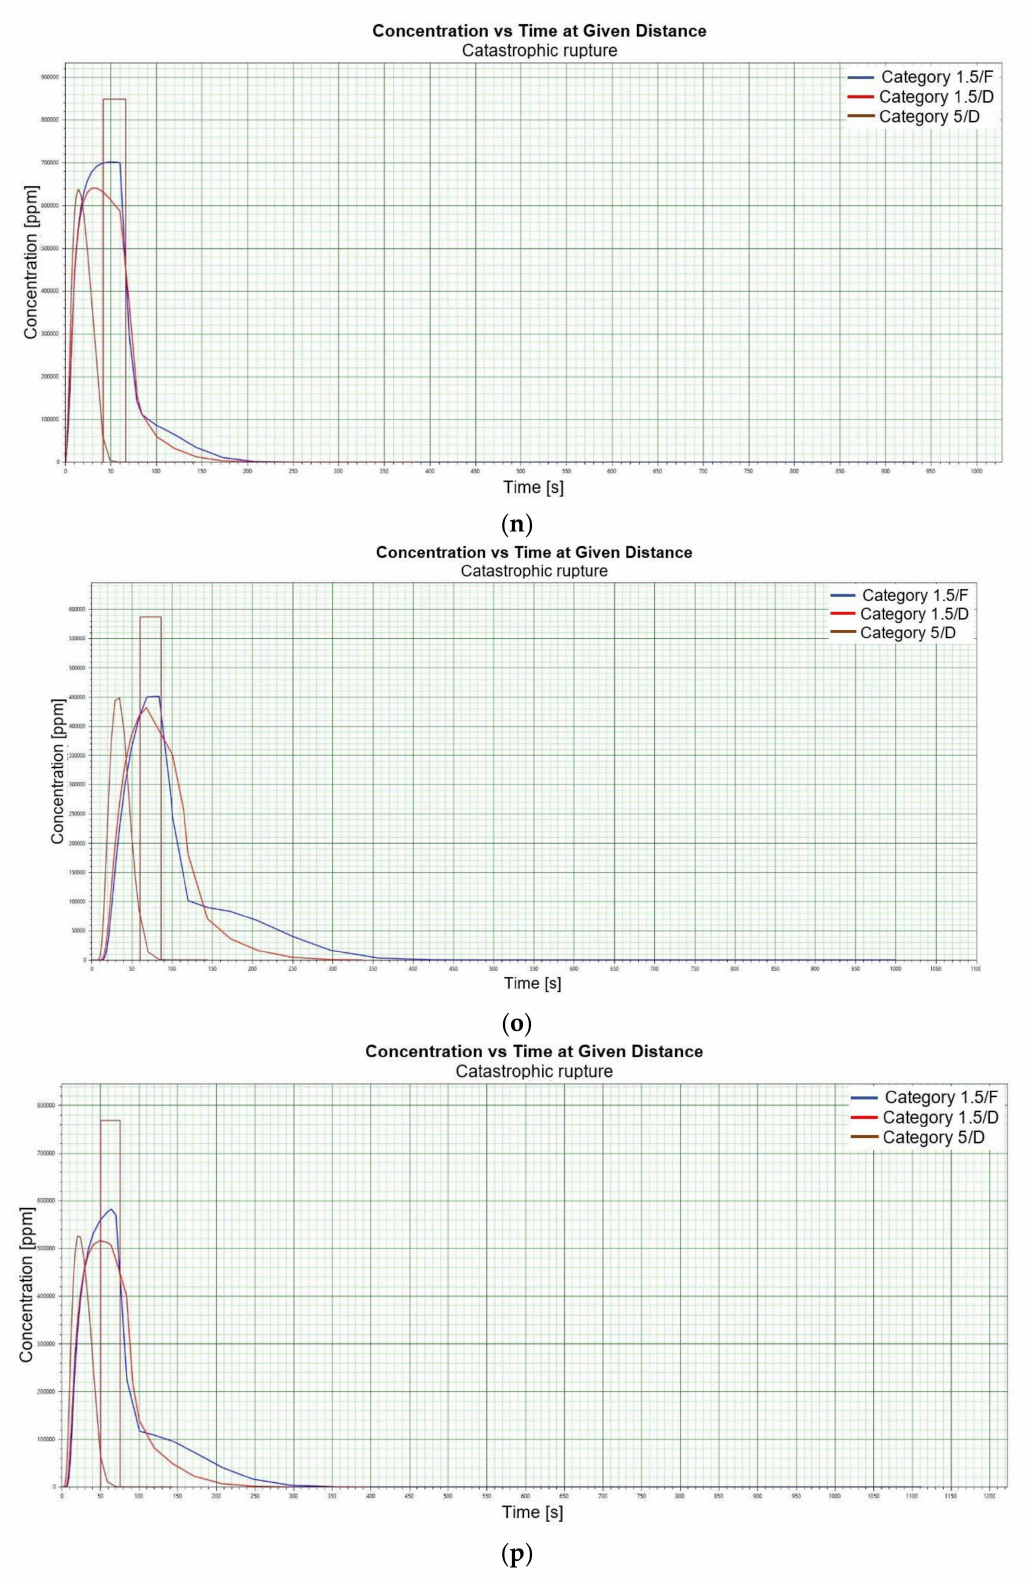
Figure 1. ( a ). Concentration vs. time for catastrophic rupture–height 1 [m] ASL LNG Light, winter. ( b ). Concentration vs. time for catastrophic rupture–height 1 m ASL LNG Light, summer. ( c ). Con- centration vs. time for catastrophic rupture–height 1 m ASL LNG Heavy, winter. ( d ).